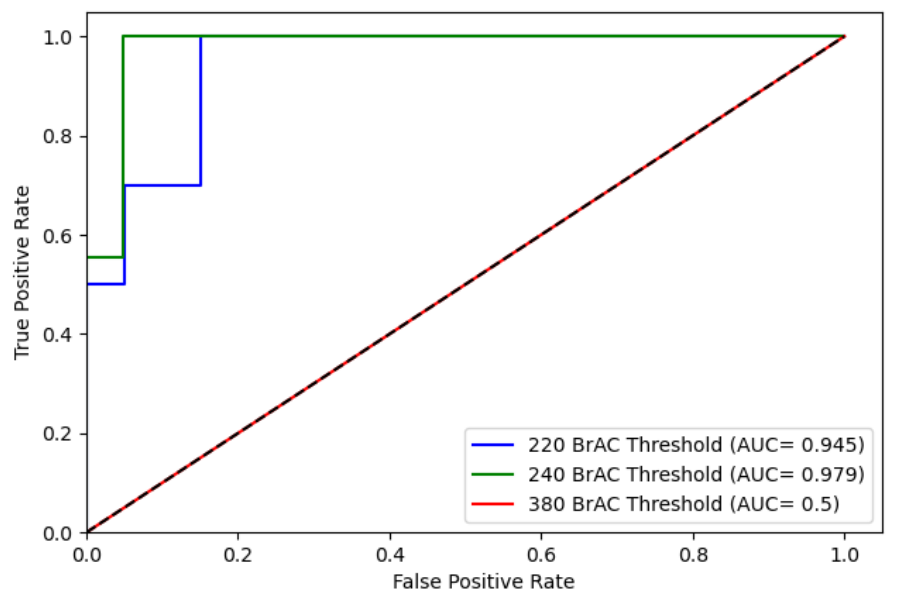
Figure 5. ROC curve of the AdaBoost classifier for BrAC thresholds of 220, 240, and 380 from data that was obtained from a smartphone and wrist-worn device.